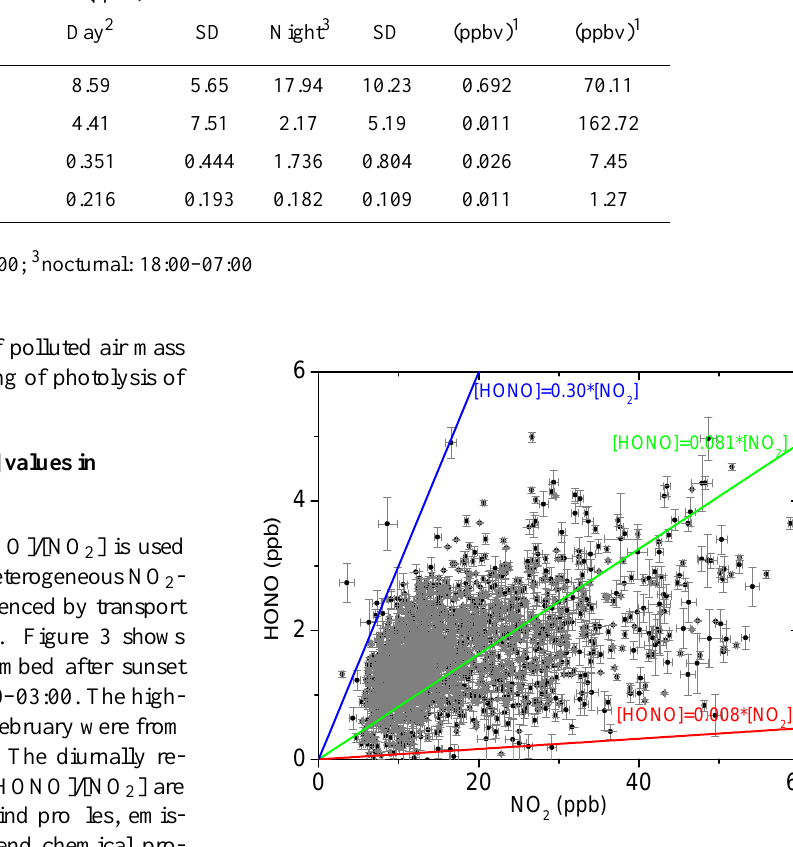
Fig. 4. [HONO] vs. [NO 2 ] in the nocturnal atmospheric boundary Figure 4. [HONO] vs. [NO ] in the nocturnal atmospheric boundary layer at an urban site of 2 layer at an urban site of Kathmandu. The error bars are 1 σ standard Kathmandu. The error bars are 1 σ standard deviation.